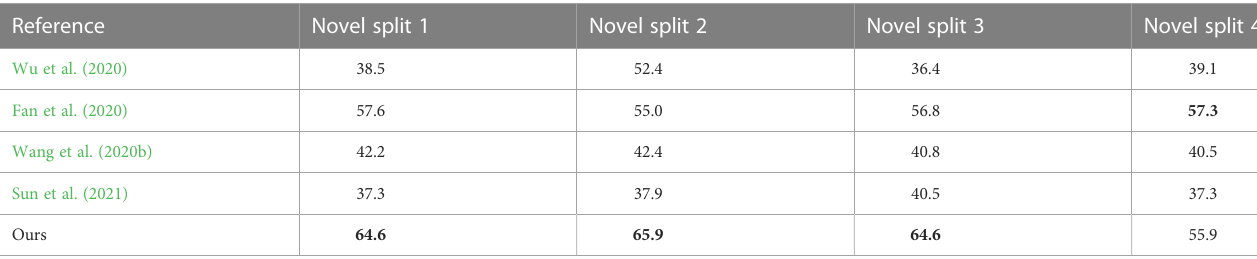
TABLE 4 FSIP52 novel classes ’ mean average recall (mAR) in 13-way 10-shot settings.